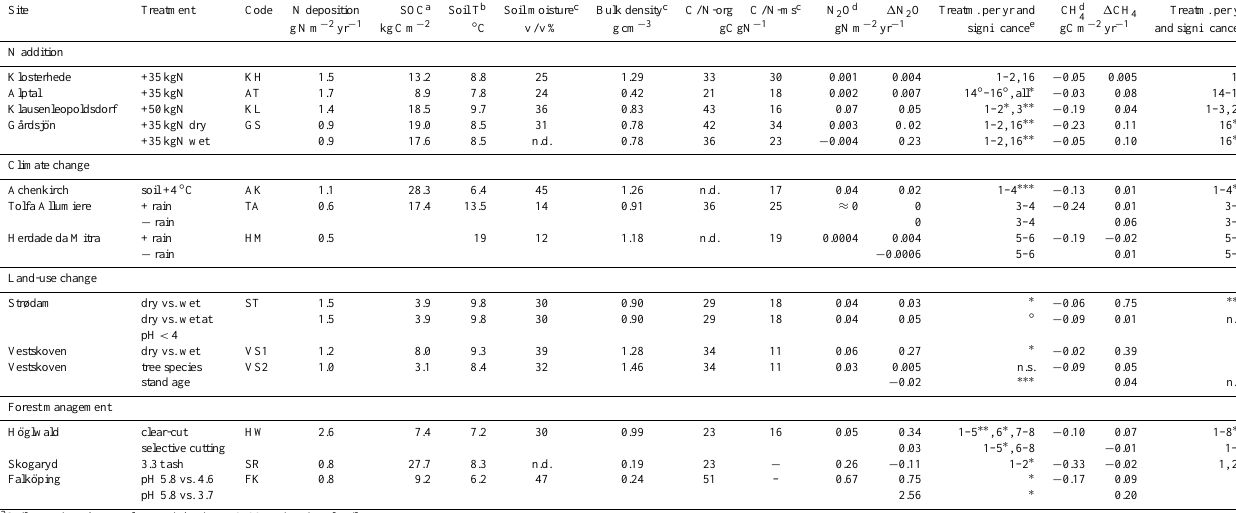
Table 3. Nitrogen deposition, soil characteristics and greenhouse gas exchange for control treatments and the response ( 1 N 2 O, 1 CH 4 ) to the forest change treatments (n.d. = not determined; n.s. = not